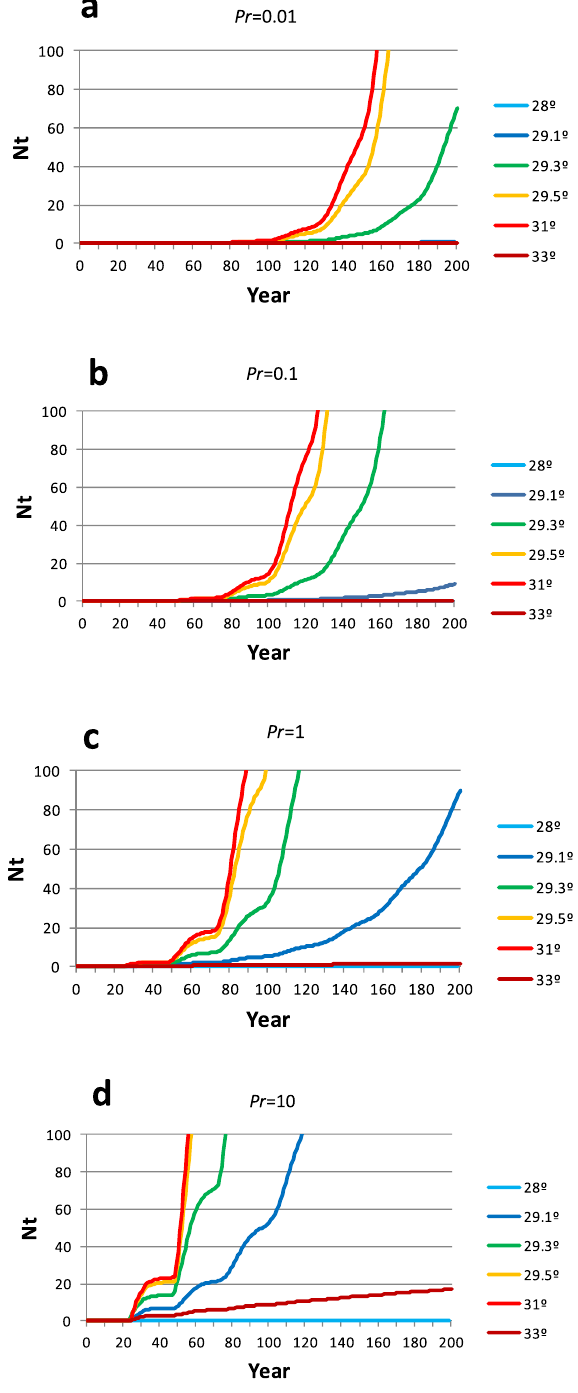
Figure 4. Model of colonisation under different incubation temperatures. The model shows the variation of the annual number of nesting females ( Nt ) during the colonisation process at different incubation temperatures and propagule pressure rates. Four different propagule pressure rates ( Pr) were modelled, ( a ) 1 sporadic nest per a hundred years ( Pr = 0.01), ( b ) 1 sporadic nest per ten years ( Pr = 0.1), ( c ) 1 sporadic nest per year ( Pr = 1) and ( d ) 10 sporadic nest per year ( Pr =